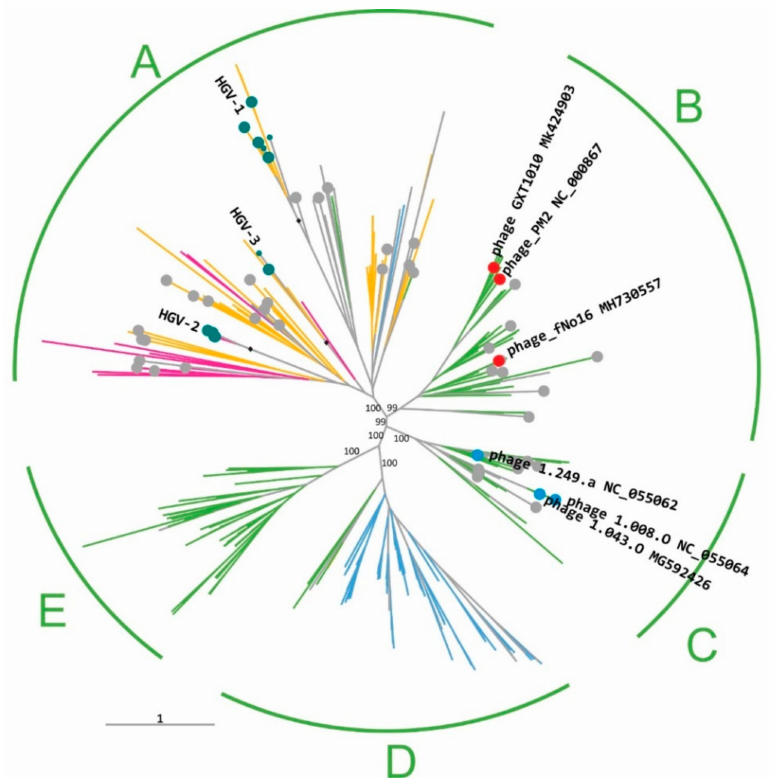
Figure 2. Phylogenetic tree of the MCP of viruses of the orfer Vinavirales . Branch color indicates predicted hosts: green, gammaproteobacteria; orange, alphaproteobacteria; blue, betaproteobacteria; magenta, Verrucomicrobia. Human gut sequences, cultured Corticoviridae and Autolykiviridae are labeled (teal, red, and blue circles, respectively). Circles mark 54 representative genomes/contigs selected for further analysis. The 5 major clades are denoted A–E, and the bootstrap support values are indicated for each of these clades. The 3 groups of MCPs from human gut microbiomes are denoted HGV1-3. The branches leading to the groups HGV1-3 all had bootstrap support values of 100 and are marked with black